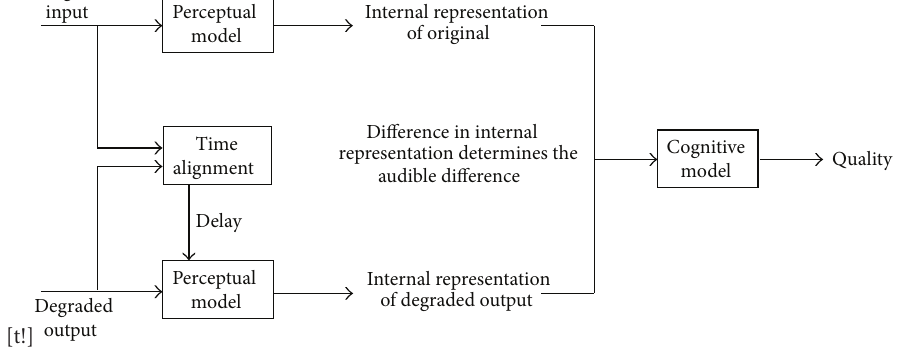
Figure 8: PESQ measure